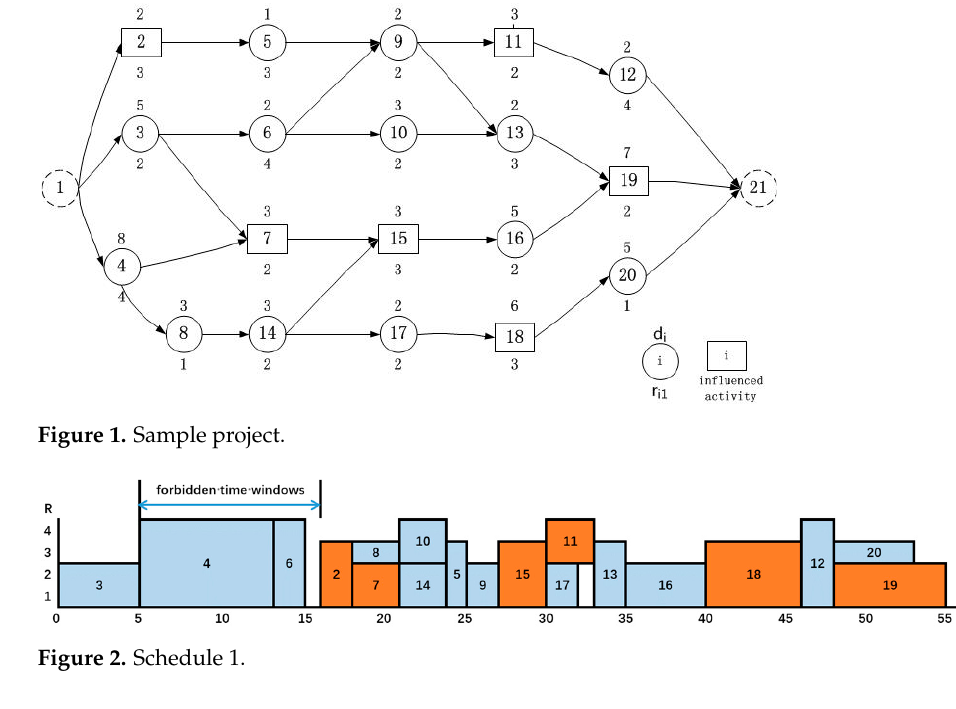
Figure 3. Schedule 2. In practice, a project may involve multiple forbidden time windows, due to the weather or to technical problems. For be tt er generalization, we regard [ST i 1 , ST i 2 ] as a for- bidden time window, and U + as the set of special activities. Thus, a RCPSP model with forbidden time windows can be described as follows. Min 𝑠 (cid:3011)